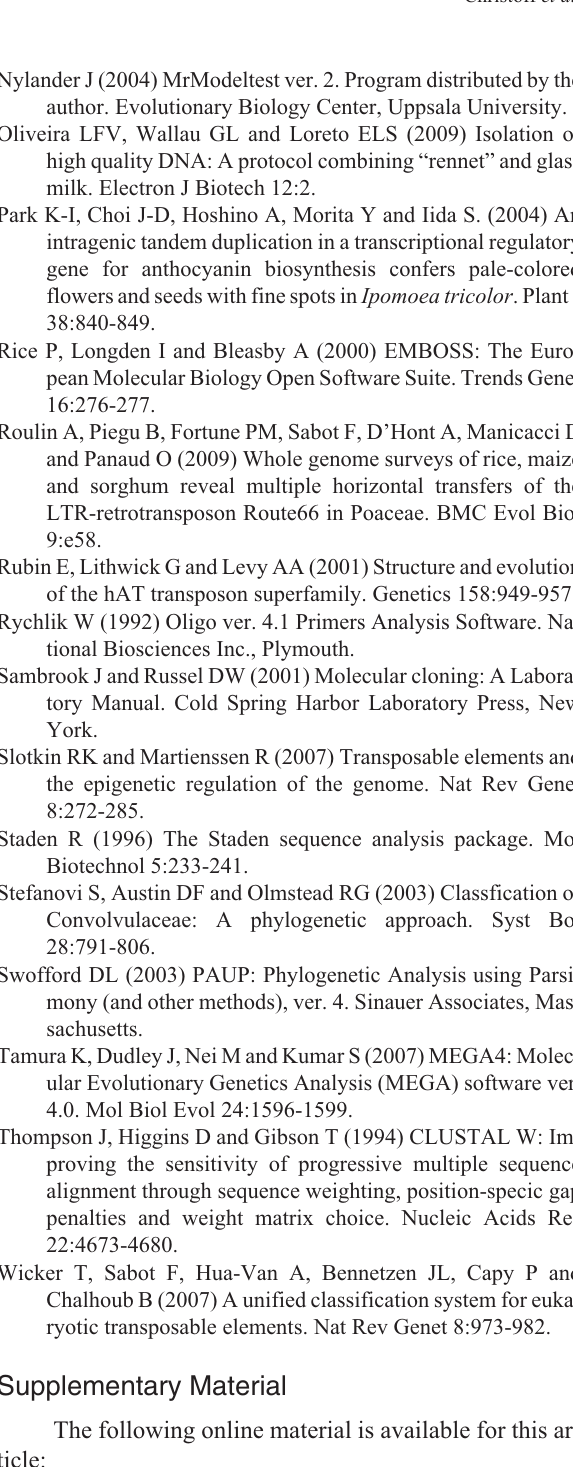
- Figure S1 - Nucleotide sequence alignment of the 5’ end of the Tip100 transposase